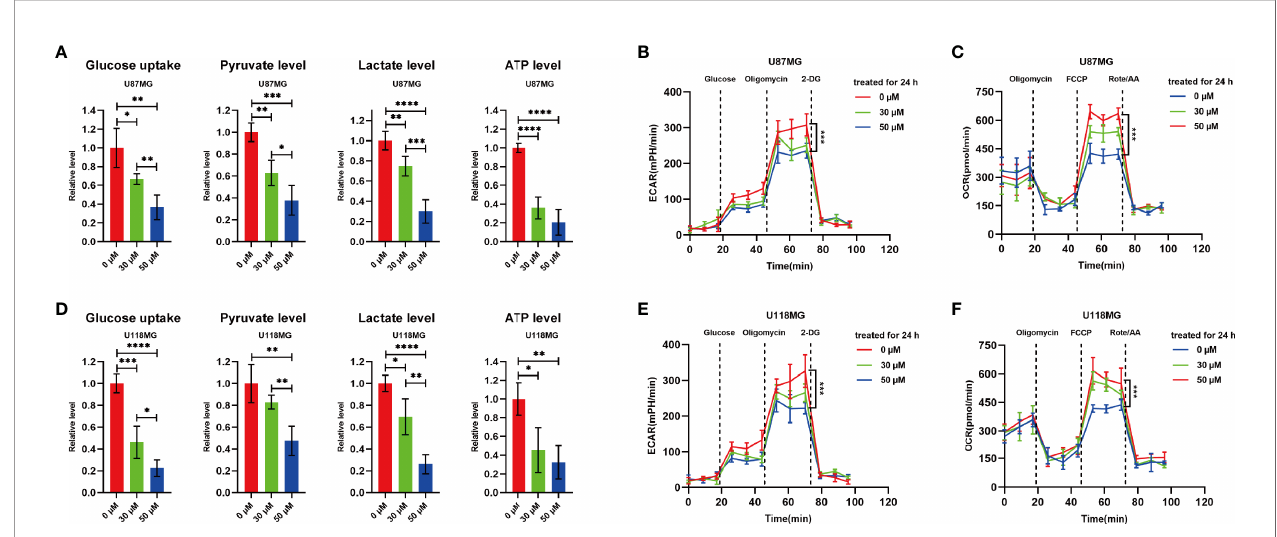
FIGURE 2 | P7C3 regulates aerobic glycolysis. (A) Glucose uptake level, pyruvate level, lactate level, and ATP level in P7C3-treated U87MG cells at a concentration of 0 m M, 30 m M, and 50 m M (n = 4). (B) Extracellular acidi fi cation rate (ECAR) assay using Seahorse XF96 Extracellular Flux Analyzer in P7C3-treated U87MG cells at a concentration of 0 m M, 30 m M, and 50 m M. (C) Oxygen consumption rate (OCR) assay using Seahorse XF96 Extracellular Flux Analyzer in P7C3-treated U87MG cells at a concentration of 0 m M, 30 m M, and 50 m M. (D) Glucose uptake level, pyruvate level, lactate level, and ATP level in P7C3-treated U118MG cells at a concentration of 0 m M, 30 m M, and 50 m M (n = 4). (E) Extracellular acidi fi cation rate (ECAR) assay using Seahorse XF96 Extracellular Flux Analyzer in P7C3-treated U118MG cells at a concentration of 0 m M, 30 m M, and 50 m M. (F) Oxygen consumption rate (OCR) assay using Seahorse XF96 Extracellular Flux Analyzer in P7C3-treated U118MG cells at a concentration of 0 m M, 30 m M, and 50 m M. (The data were expressed as mean ± SD, * P < 0.05, ** P < 0.01, *** P < 0.001, **** P <